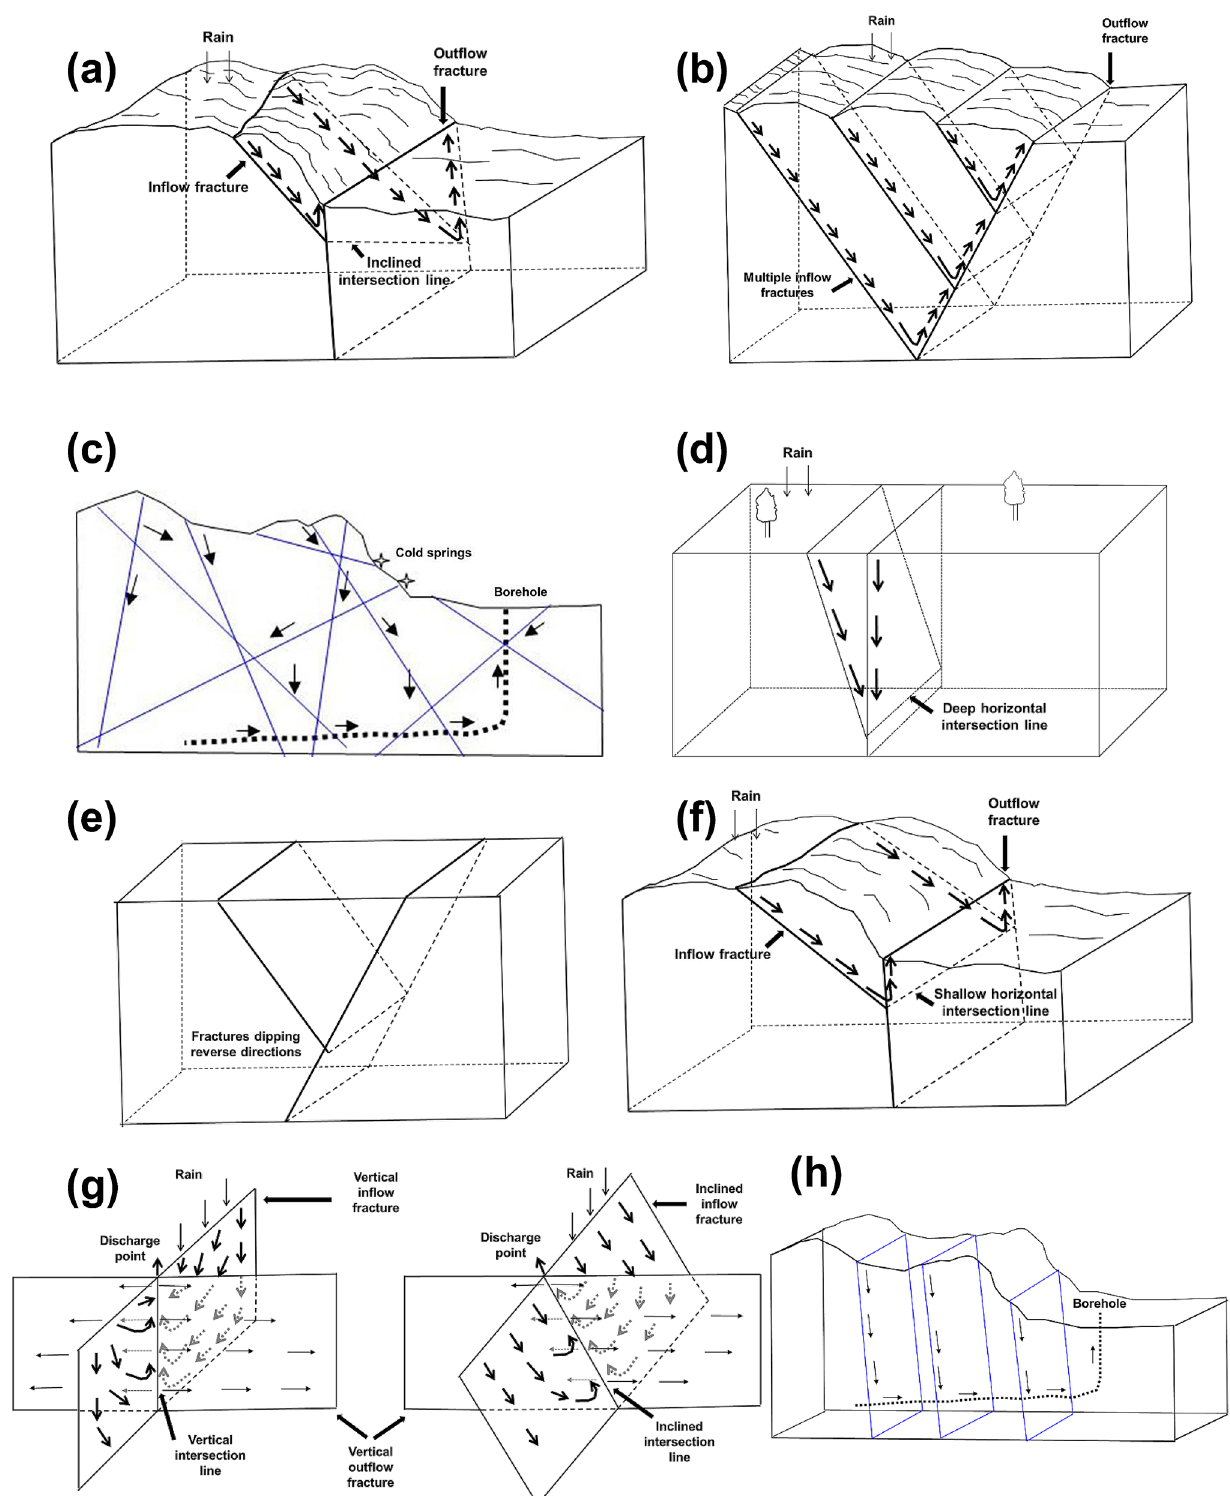
of parallel strikes, f Shallow intersecting parallel strike fractures, g intersection of unparalleled fracture planes, h non-intersecting par- allel fracture